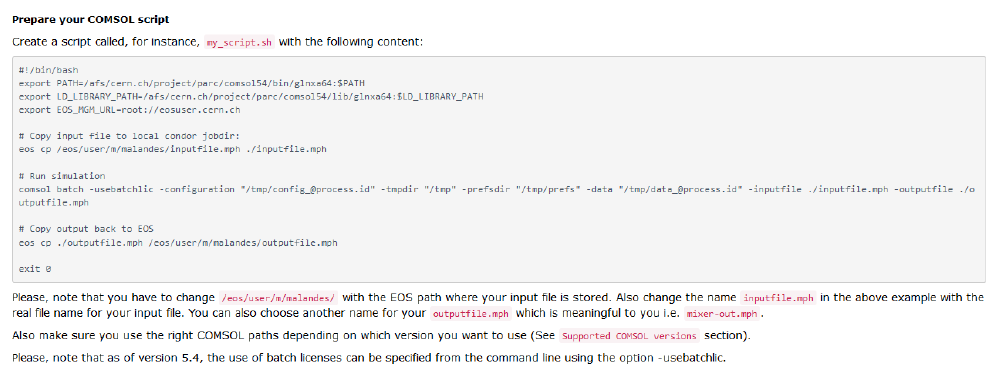
of high frequency (HF) devices such as antennae, filters, couplers, planar and multi-layer structures. CST software makes available Time Domain and Frequency Domain solvers. CST MWS o ff ers further solver modules for specific